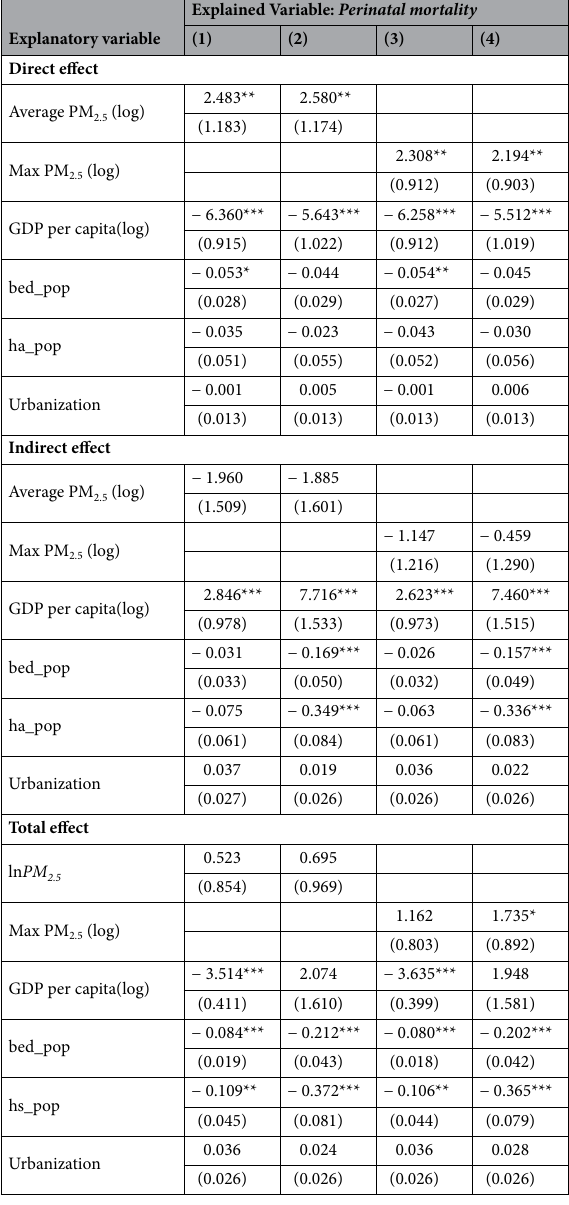
Table 6. Decomposition of direct effect, indirect effect, and total effect. Clustered standard in parentheses, * p < 0.1, ** p < 0.05, *** p <